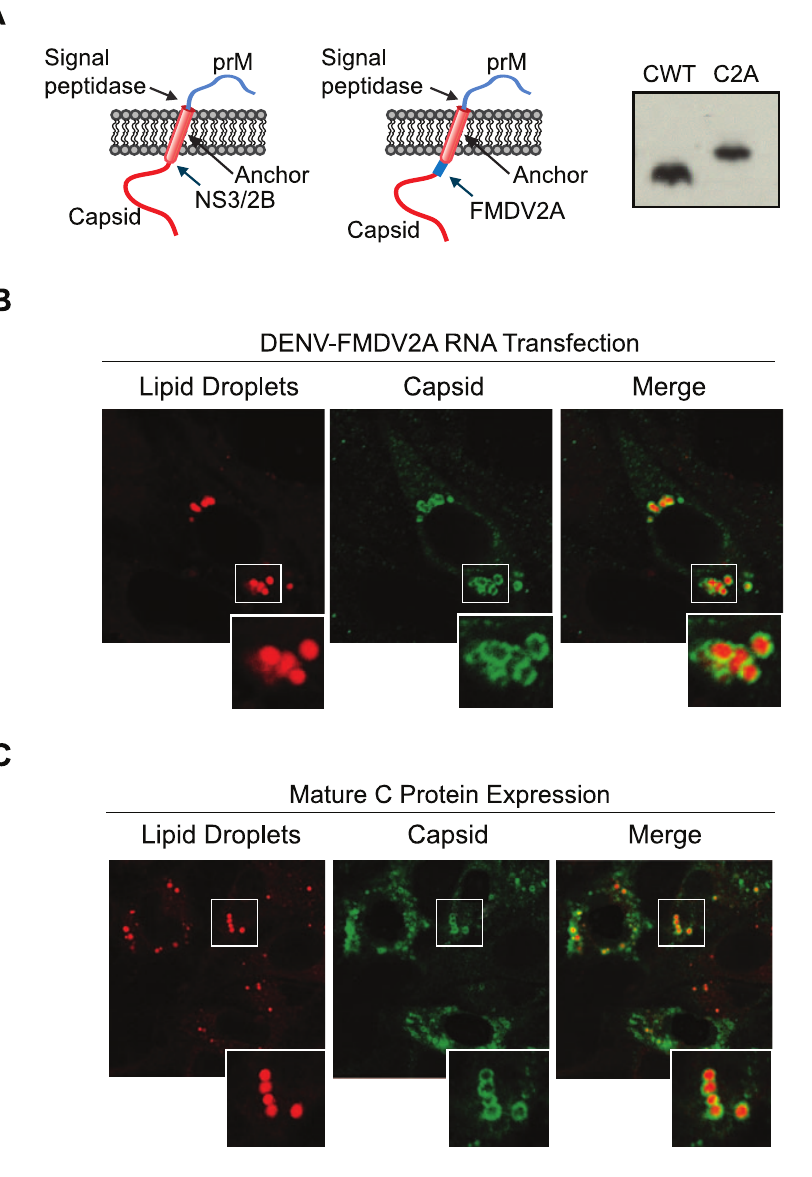
Figure 2. The C protein contains the structural determinants for LD targeting. A. Schematic representation of the topology of the viral C and prM proteins on the ER membrane. The anchor peptide and the cleavage sites of the signal peptidase and viral NS3/2B proteases are indicated. The location of the FMDV2A protease replacing the NS3/2B site is shown in the scheme on the right. The western blot shows expression of the C protein in cytoplasmic extracts of cells transfected with a full length DENV RNA WT (Cwt) or the RNA including the FMDV2A site (C2A). B. The anchor peptide is dispensable for C accumulation on LDs. BHK cells transfected with the DENV-FMDV2A RNA were fixed and probed with antibodies against C and BODIPY to stain neutral lipids in LDs, as indicated on the top. C. Expression of the mature C protein in the absence of other viral components is sufficient for LD targeting. BHK cells were transfected with an expression plasmid that encode the mature form of DENV C protein. Twenty four h post-transfection cells were fixed and probed with anti-C antibodies followed by staining of lipid